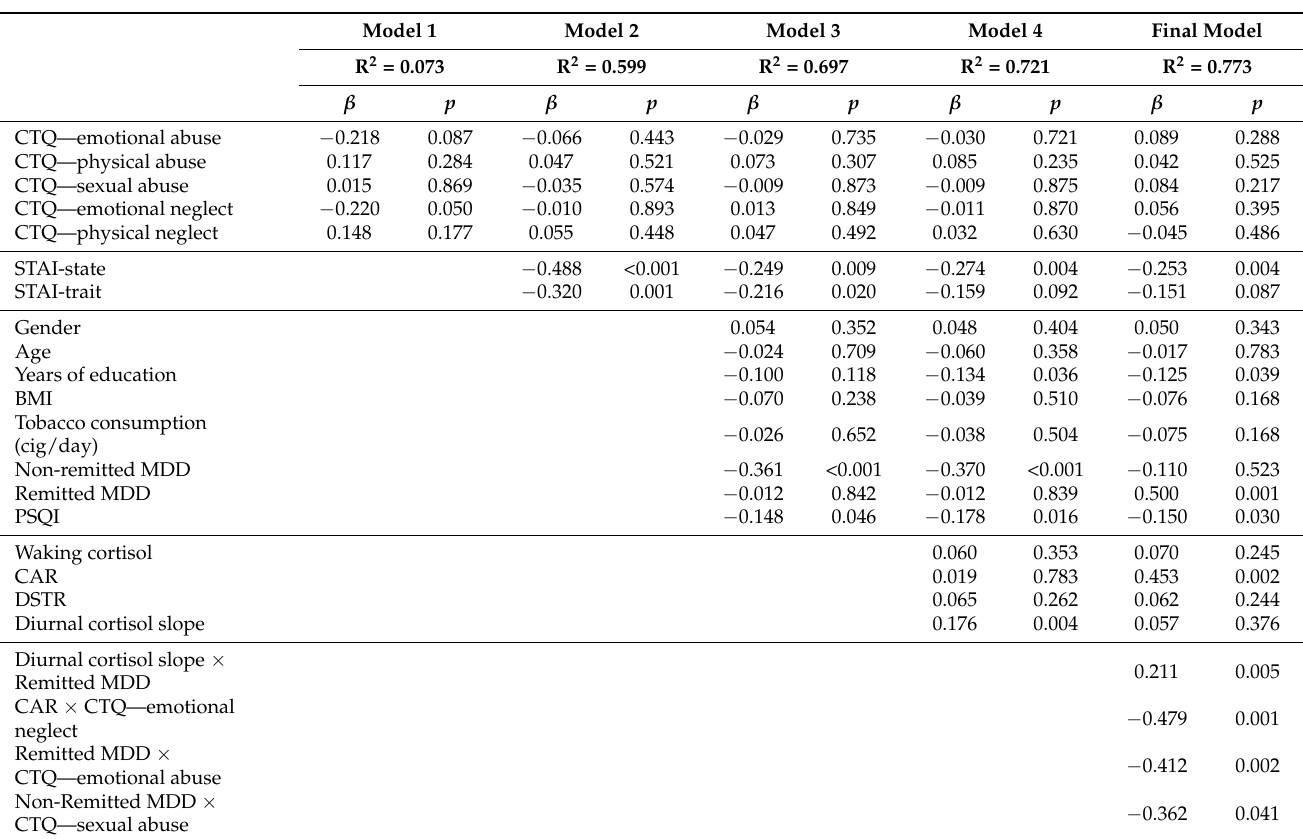
Table 4. Results of multiple linear regression analyses exploring the association of childhood maltreatment, HPA axis function, and MDD remission status with quality of life (EQ-VAS) in all participants ( n =